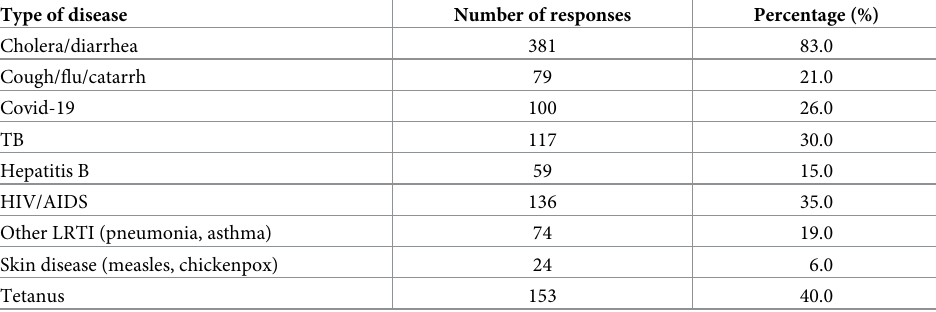
Table 3. Diseases associated with solid medical waste as reported by household respondents. Type of